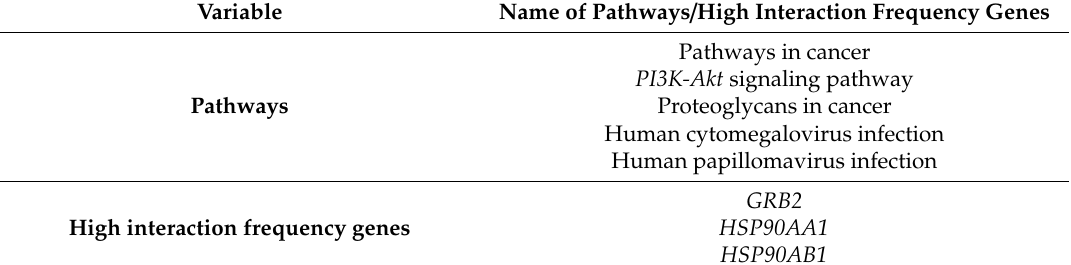
Table 5. Gene signature-related pathways and high interaction frequency genes associated with PCRT